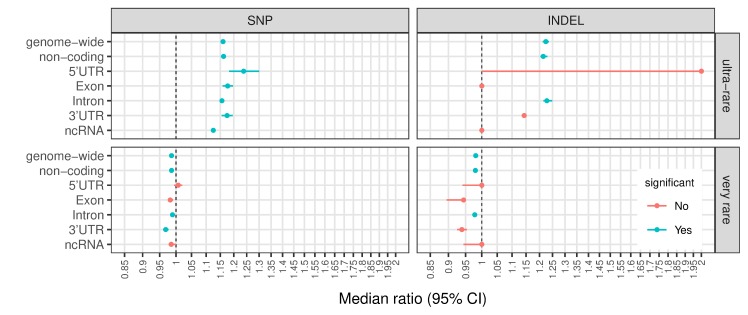
Significant differences in variant load in coding and related regions for ultra-rare (upper panel) and very rare (lower panel) variants.Circle dots represent the ratio of the median number of variants in a VIKING individual to the median number of variants in an LBC individual; whiskers are 95% CI based in 10,000 randomly selected LBC subsets (n = 269, with replacement). Significance: at least 95% of the 10,000 subsets have p-value ≤ 8x10-4 (Bonferroni corrected) and no overlap between the 95% CI for the LBC and the VIKING median values (for full results see S4 Fig). The higher variance in the 5’UTR and lower variance in ncRNA regions could be explained by their relatively small sizes– 9.3Mb and 7.3Mb, respectively.